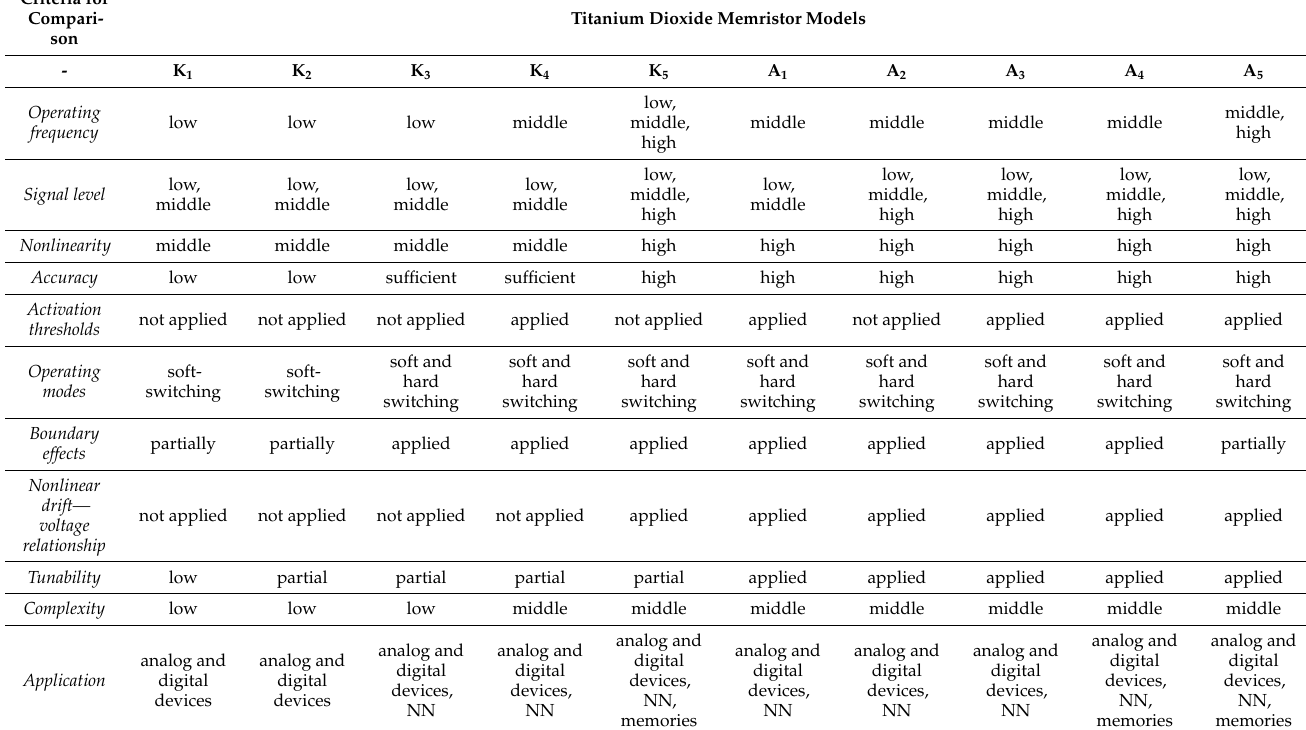
Table 1. A comparison of the considered existing and modified TiO 2 memristor